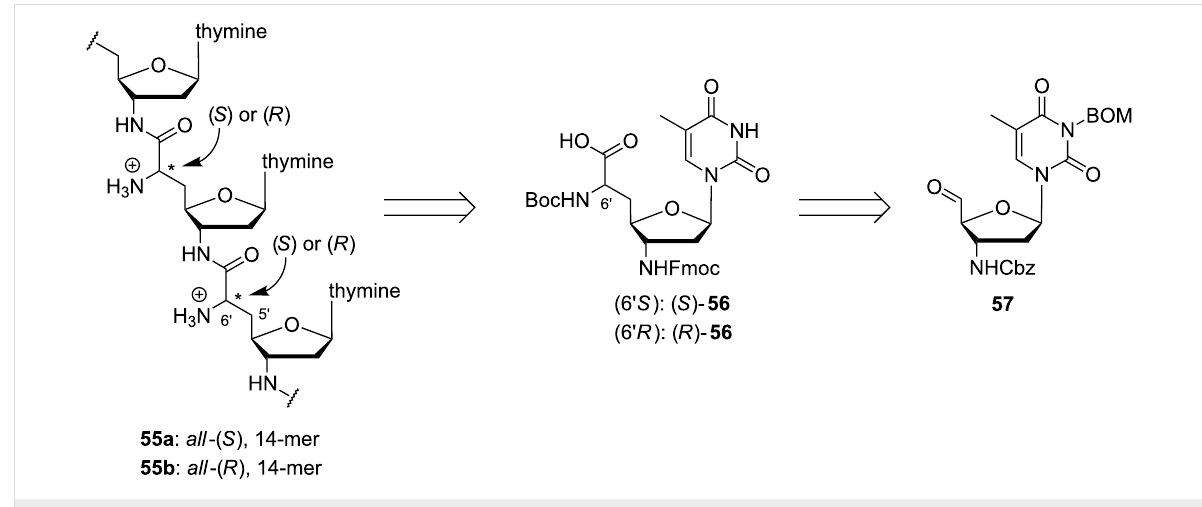
Scheme 6: Retrosynthetic summary of Ducho's and Grossmann's synthesis of fully cationic NAA-modified oligonucleotides 55a and 55b